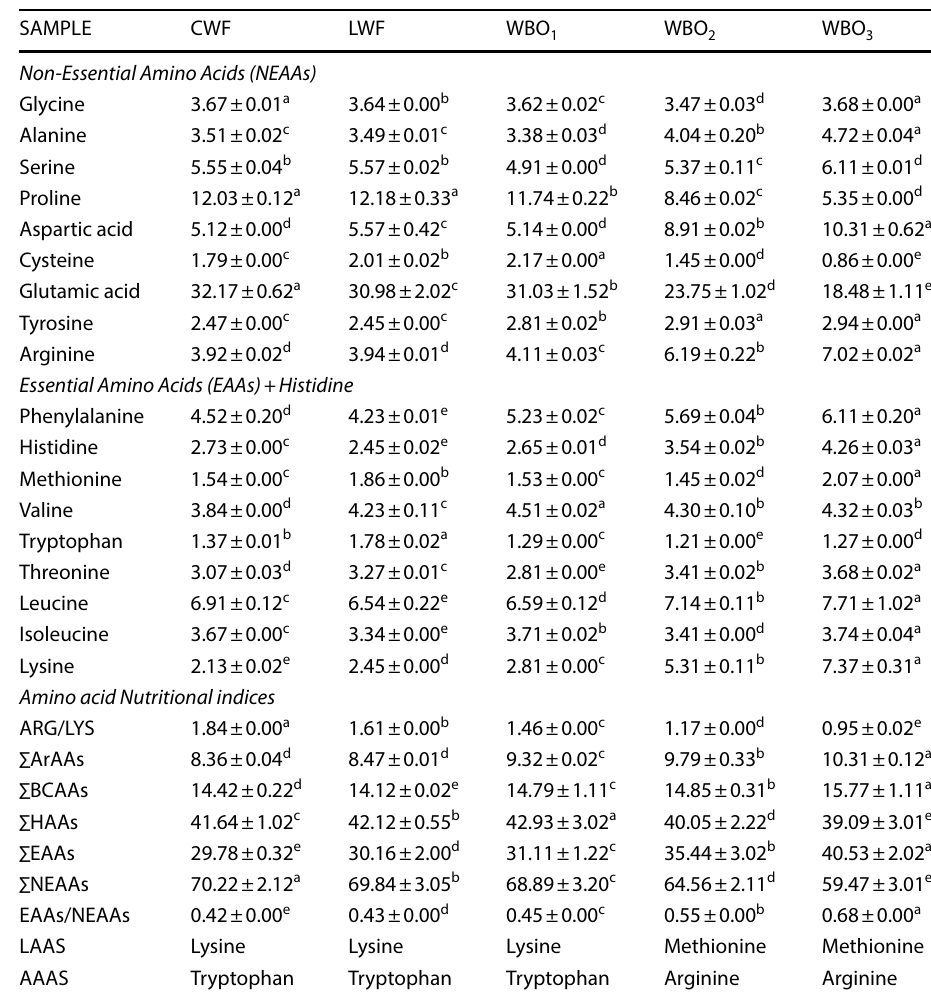
Means ( ± SD) with different alphabetical superscripts in the same row are significantly different at P < 0.05. [75% wheat, and 25% bambara groundnut